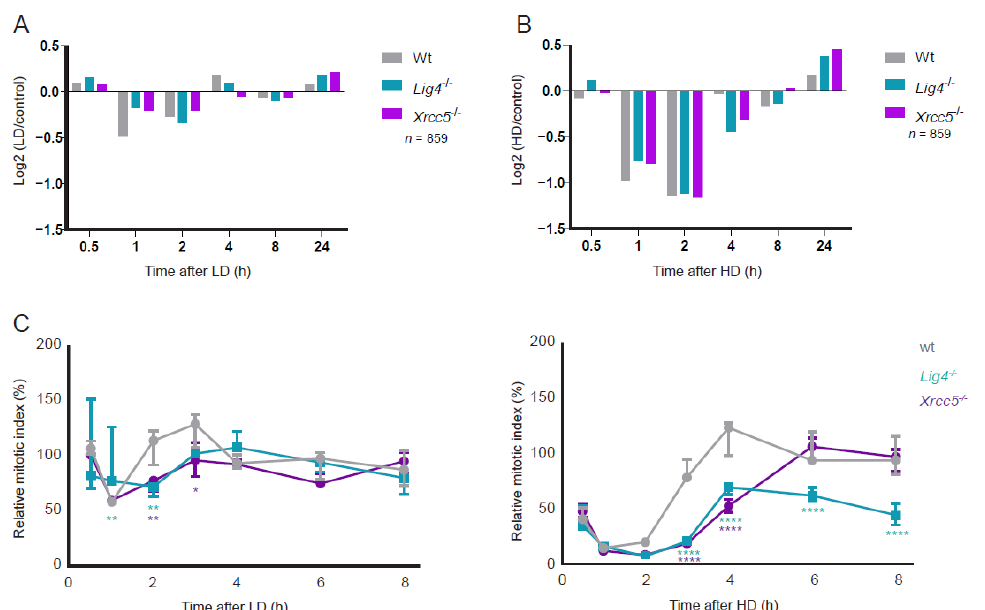
Figure 4. G2/M checkpoint dynamics: ( A , B ) Bar chart of relative median phosphorylation of 859 cluster B phosphosites after LD and HD in wt and DRD cells. ( C ) Relative mitotic index (in % of metaphases in IR-exposed cells over mock-exposed cells) of wt, Lig4-/- and Xrcc5-/- cells in response to LD (left panel) and HD (right panel). Statistics: two-way ANOVA with a post hoc Dunnett’s test at 95% CI between wt and Lig4-/- or Xrcc5-/-. (* p -value < 0.05, ** < 0.01 and **** < 0.0001). These results indicate that impaired DSB repair alters the dynamic properties of DDR signaling cascades and that G2/M checkpoint recovery is independent of DSB repair com- pletion. 3.3. Multi-Site Dephosphorylation of Cell Cycle Proteins Activates the G2/M Checkpoint in mESC.